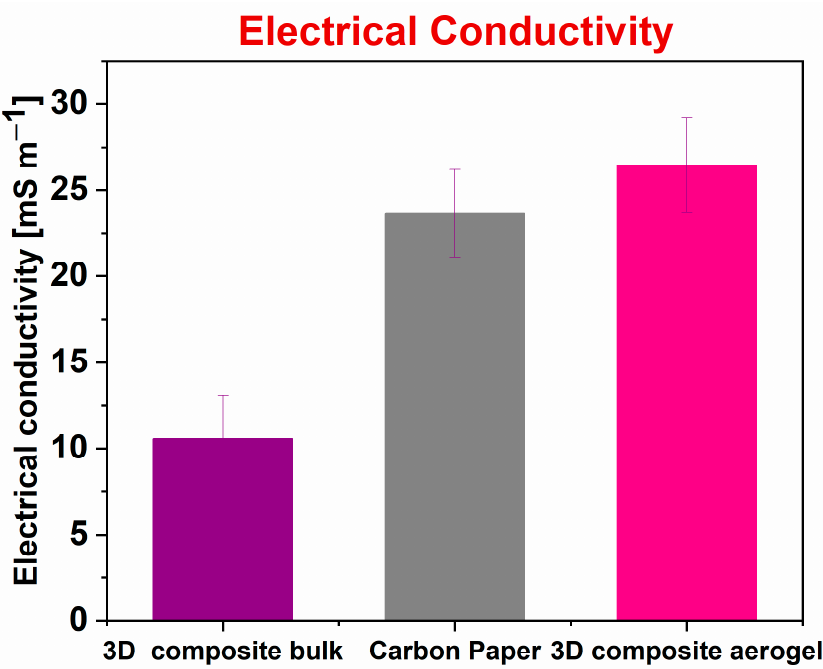
Figure 3. Electrical conductivity obtained for each sample: 3D composite bulk (purple rectangle), carbon paper (CP) (grey rectangle), and 3D composite aerogel (magenta rectangle). The 3D composite bulk and 3D composite aerogel were both made of PDMS and 5 wt% of MWCNTs. To obtain these results, all electrical characterizations were performed on 10 samples for each structure.